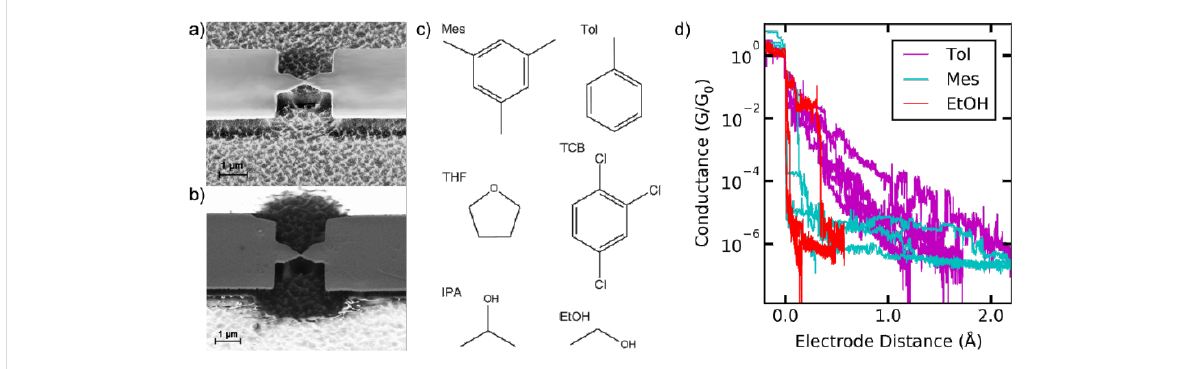
Figure 2: a) Electron micrograph of an Au MCBJ before and b) after measurement in TCB, c) structures of the solvents under study. d) Examples of stretching traces in different